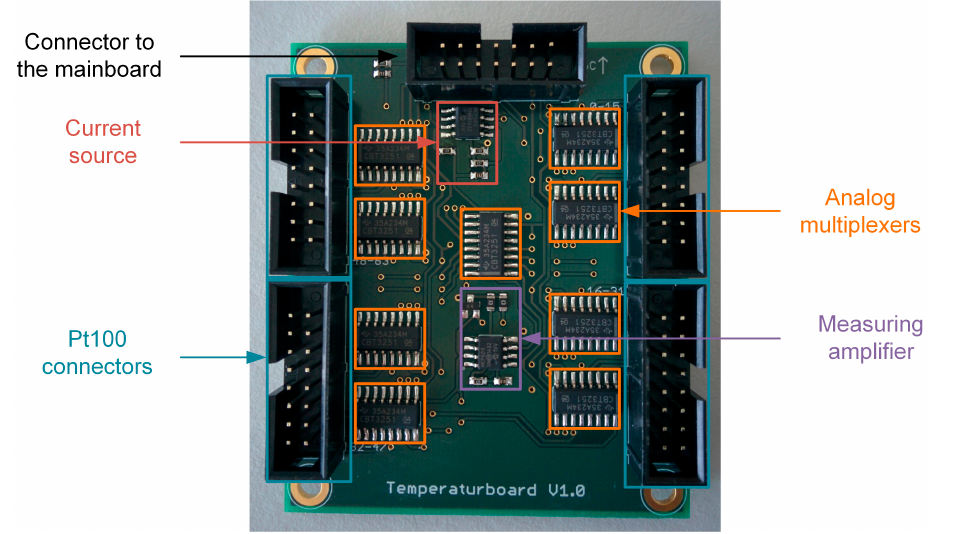
Figure 8. Top view of the temperature board.